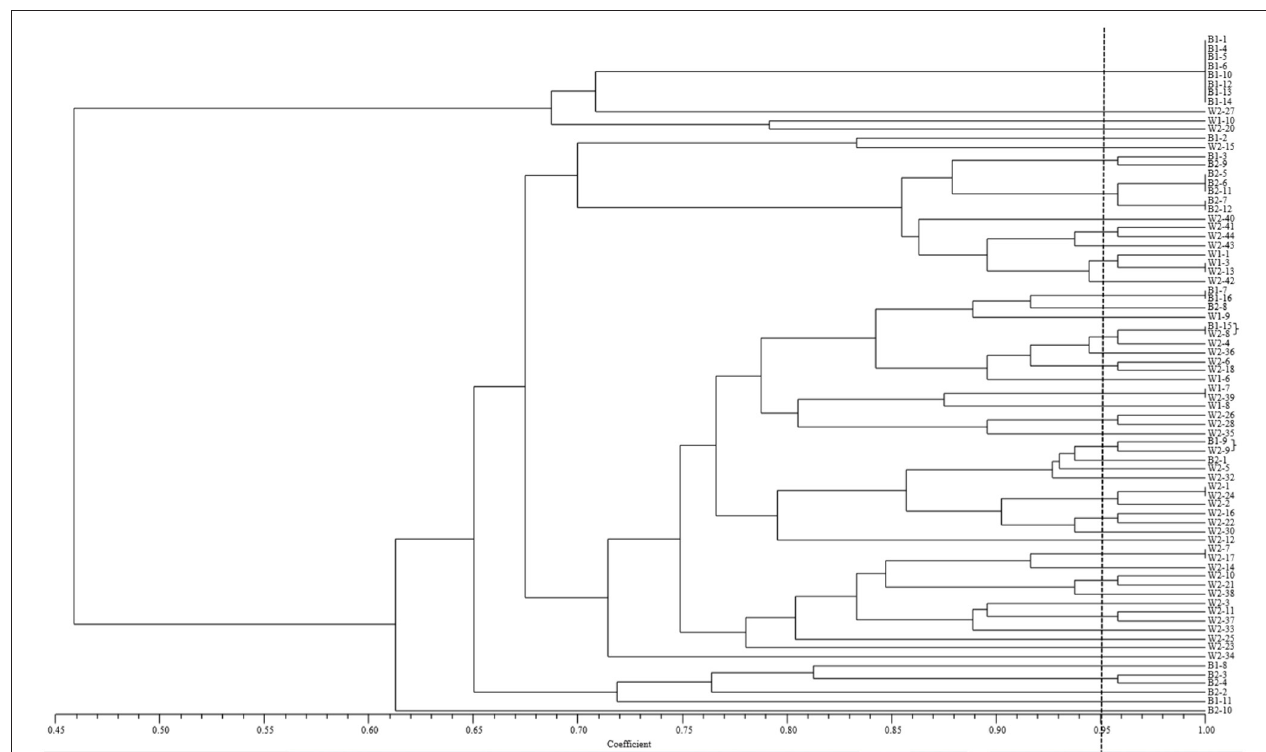
FIGURE 5 | Clustering based on the simple matching (SM) coefficient of Puccinia striiformis f. sp. tritici isolates virulent to the 24 single Yr gene lines as differentials. Isolates of B1-1 to B1-16 of Puccinia striiformis f. sp. tritici recovered from rusted barberry bushes on 11 June, 2018, and those of B2-1 to B2-13 from barberry on 25 June, 2018. Isolates of W1-1 to W1-10 of P. striiformis f. sp. tritici collected from wheat in the vicinity of barberry bushes on 17 June, 2018, and those of W2-1 to W2-44 from nearby wheat on 25 June, 2018.